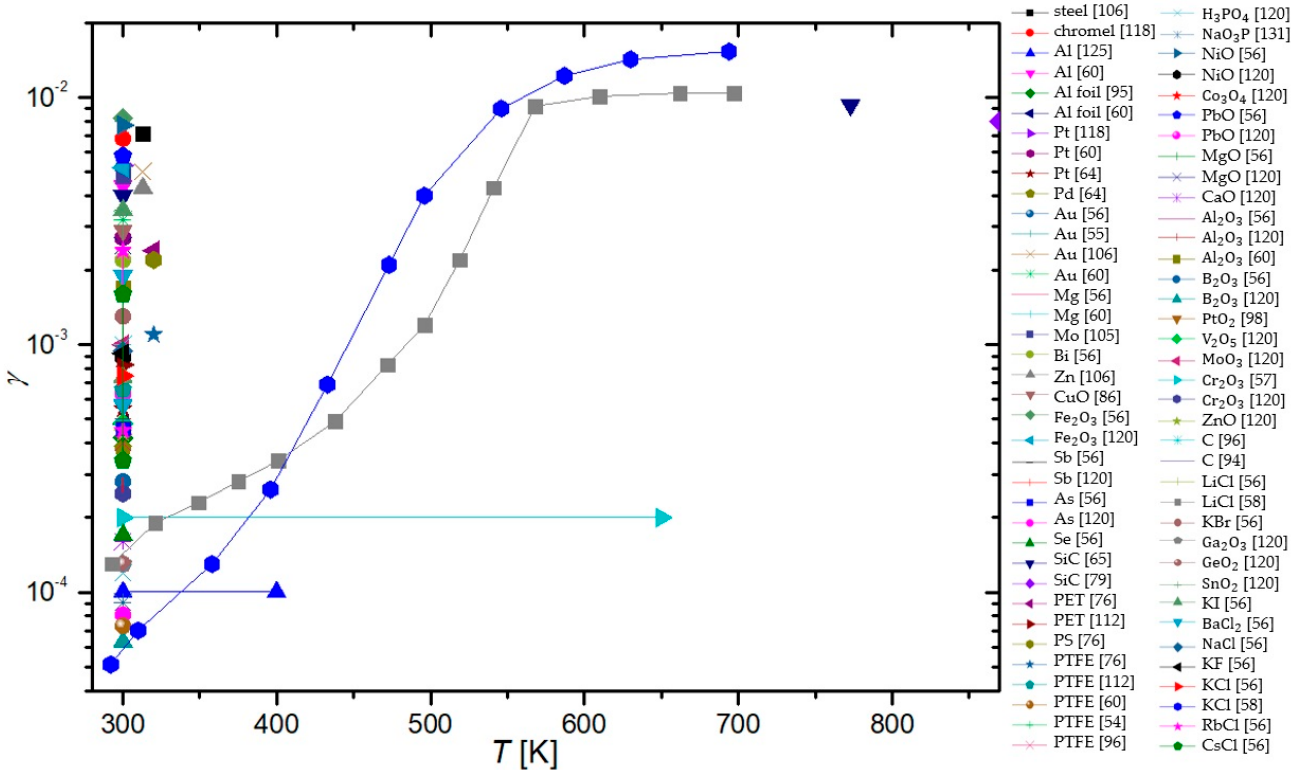
Figure 23. Recombination coefficient ( γ ) of neutral oxygen atoms versus surface temperature ( T s ) for various inert surfaces.